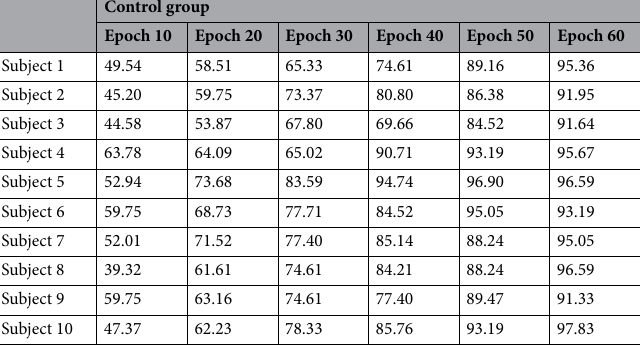
Table 1. The accuracies obtained on the control group from a range of epochs up to 60 (with increment of 10).